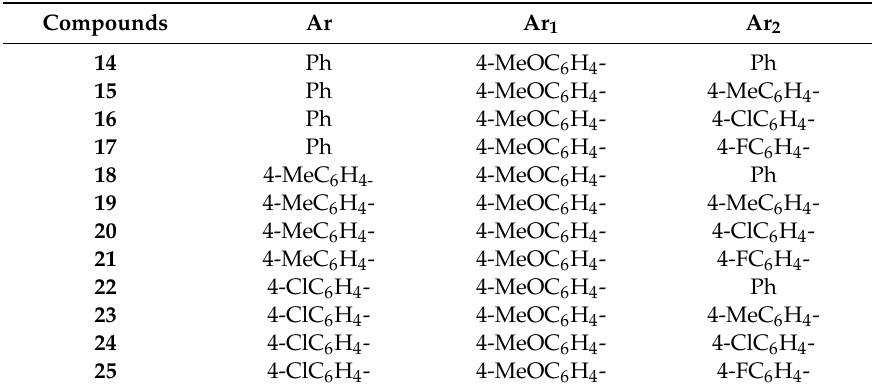
Scheme 1. Synthesis of Schi ff bases 14 – 25 . Table 1. Schi ff bases 14 – 25 Table 1. Schiff bases 14 – 25